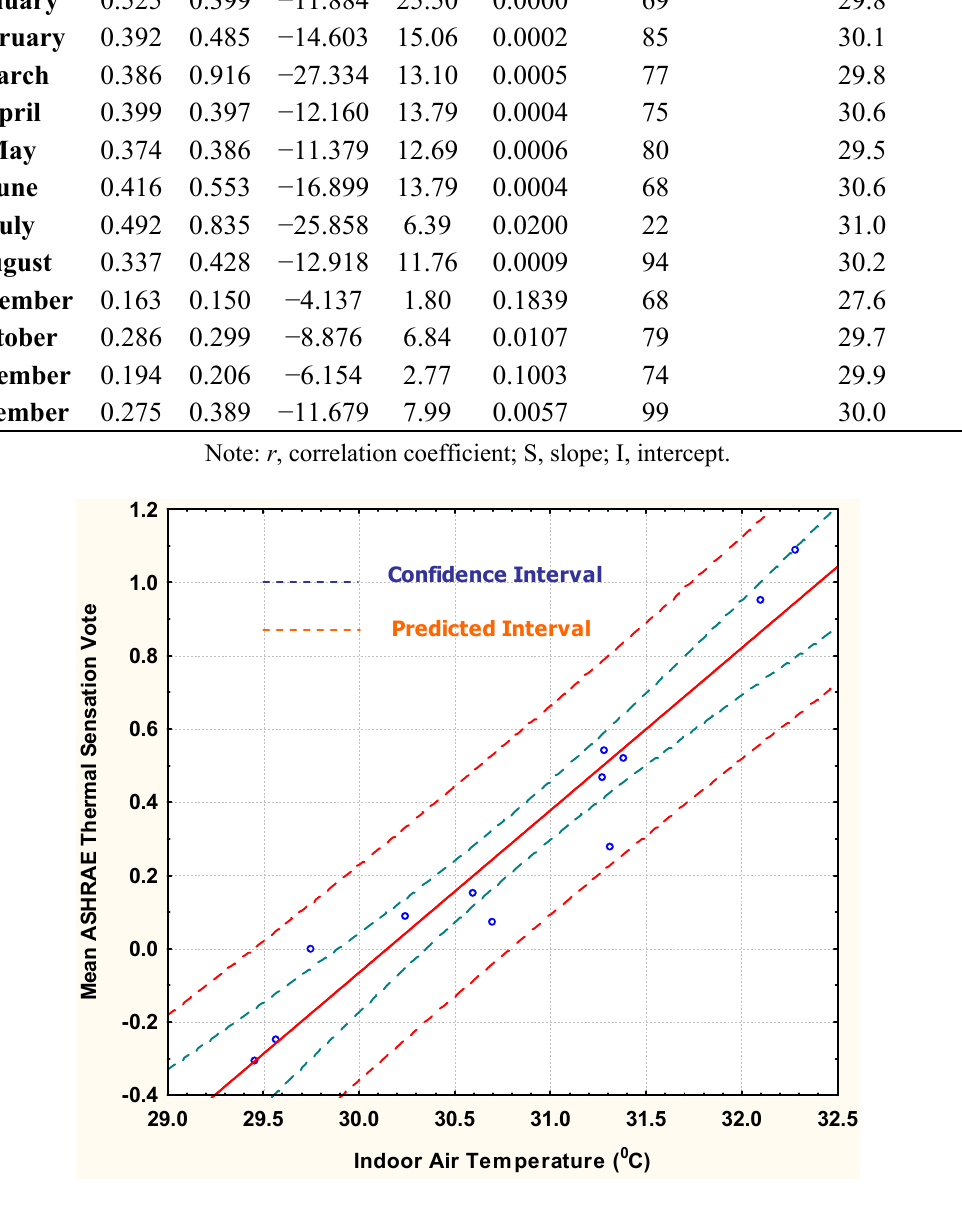
Figure 3. Monthly mean air temperature (°C) vs. mean votes on the ASHRAE